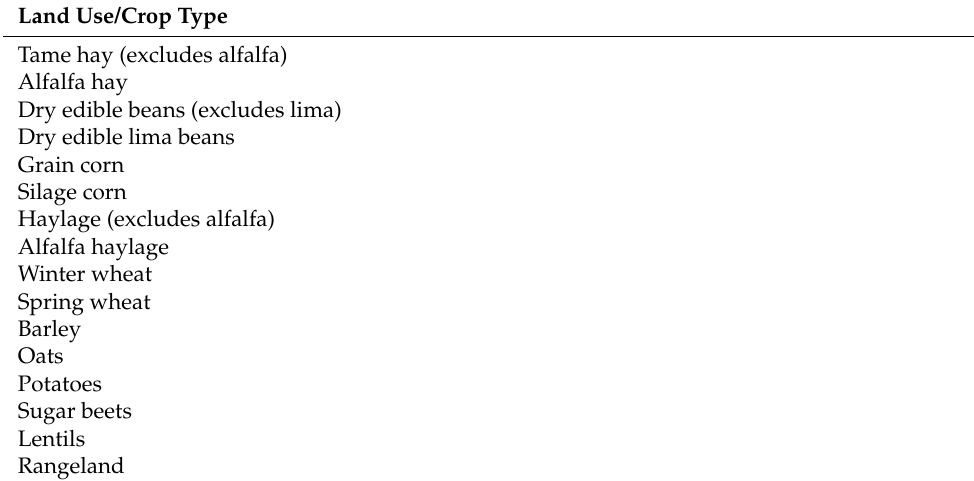
Table 1. Potential crops and land use scenarios that could be converted to growing